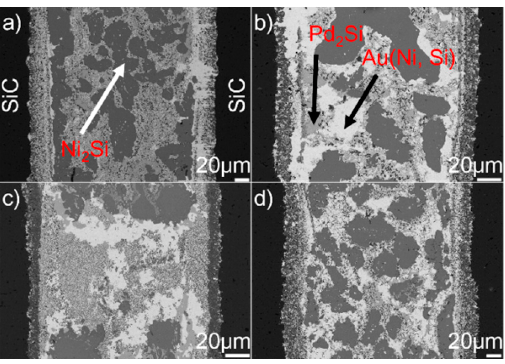
Figure 5. BSE images showing the microstructure of the SiC/SiC joints brazed for 10 min at different temperatures: ( a ) 1423 K; ( b ) 1473 K; ( c ) 1523 K; ( d ) 1573 K.